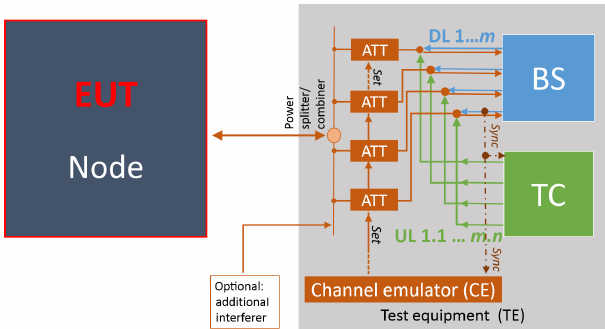
Figure 9. Sketch of the DL and UL signals for node testing. The parts of the hardware setup that generate the corresponding signals are denoted in italics.